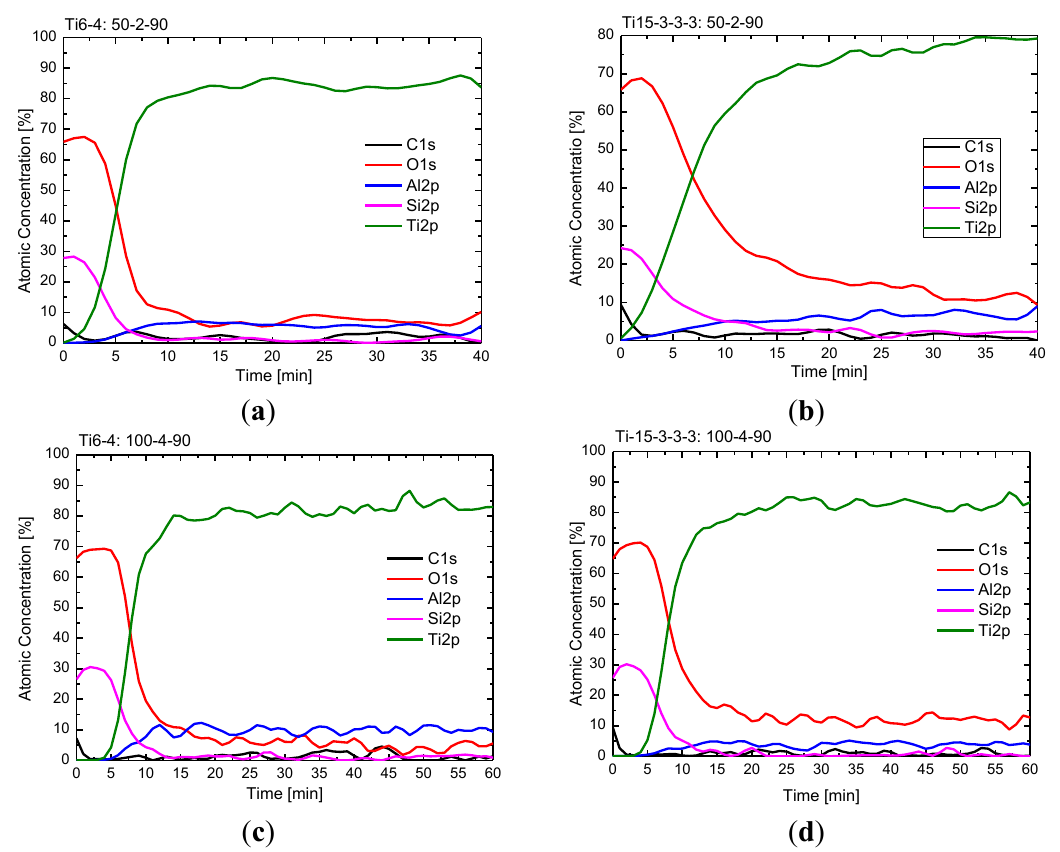
Figure 4. Depth profile of the hexamethyldisiloxane (HMDSO) derived coating obtained with the supply rate of 7 nm/min (sample nomenclature: Ti15-3-3-3 = Ti 15 V 3 Cr 3 Sn 3 Al, Ti6-4 = Ti 6 Al 4 V, 50 (nominal thickness [nm])–2 (working distance [cm])–90 (tilting angle/sample position)). ( a ) Ti6-4: 50-2-90; ( b ) Ti15-3-3-3: 50-2-90; ( c ) Ti6-4: 100-4-90; ( d ) Ti15-3-3-3: 100-4-90.